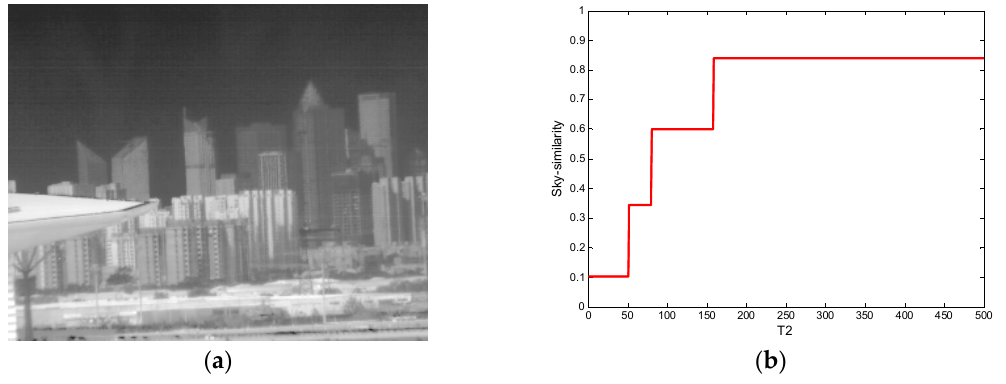
Figure 18. Sky similarity with different T 2 for half-sky image. ( a ) A half-sky image; and ( b ) the corresponding sky similarity curve.